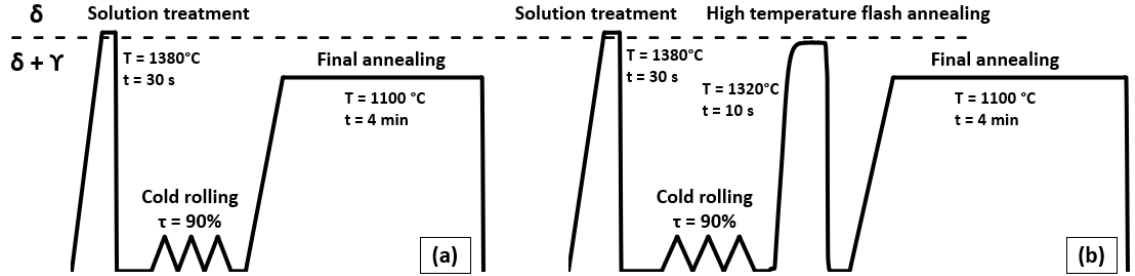
Figure 3. Thermomechanical treatments used to elaborate an ( a ) ultrafine microstructure and ( b ) equiaxed microstructure of superduplex stainless steel 2507.